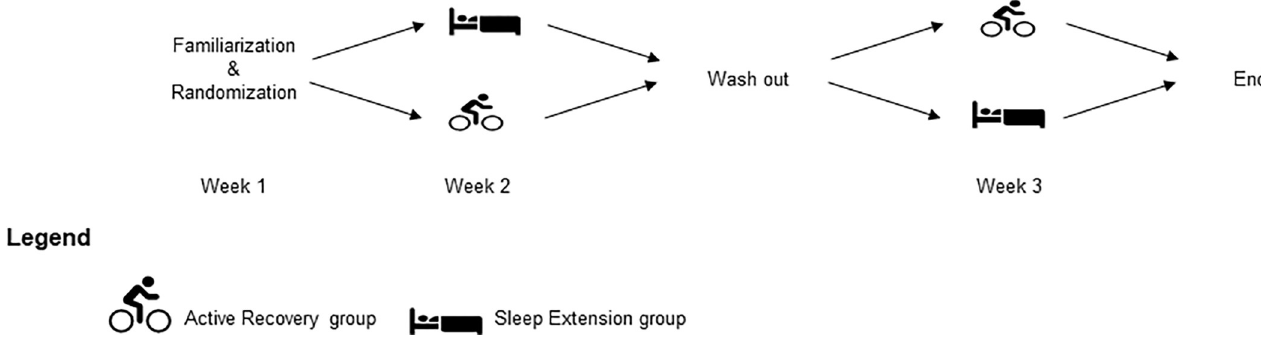
Fig 1. General study